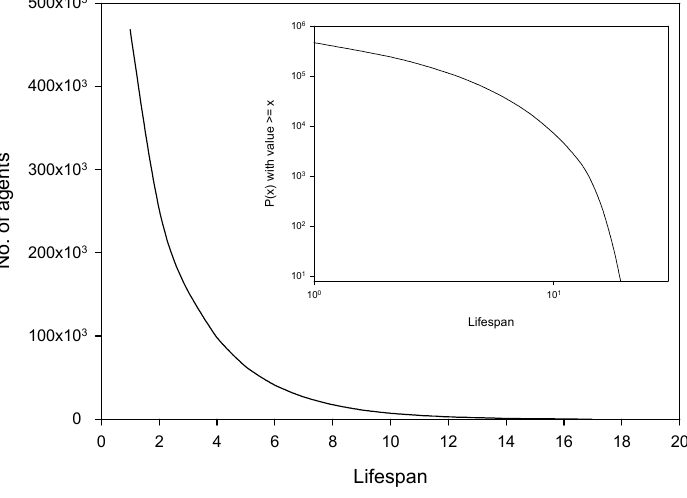
<Figure 4.1> Lifespan distribution for social